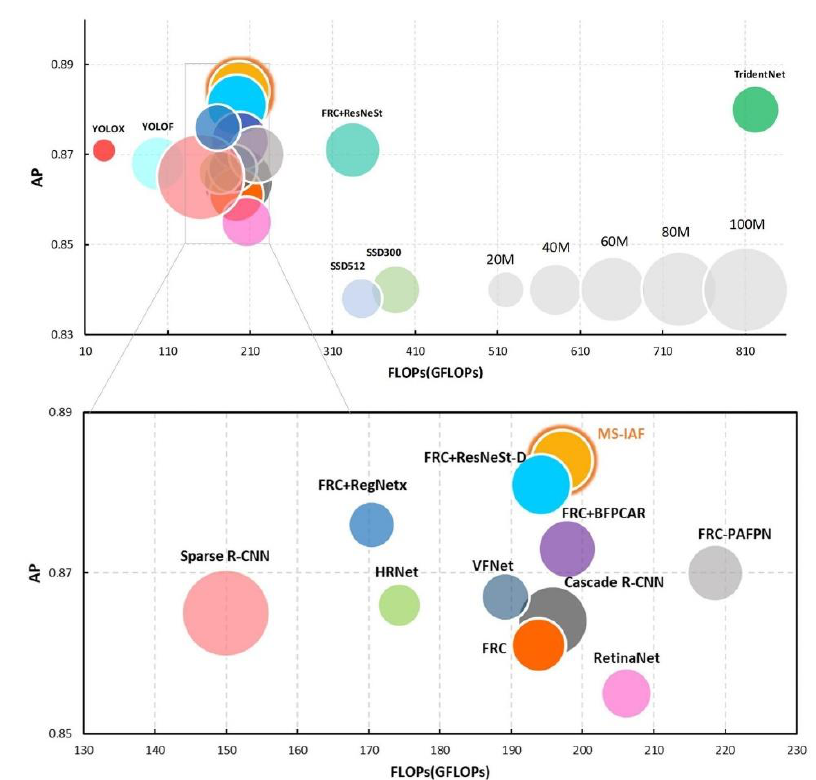
Figure 6. AP vs. FLOPs, size ∝ Params. (The vertical axis represents the average AP, the horizontal axis represents the FLOPs of the model, and the size of the circle represents the parameters of the model).